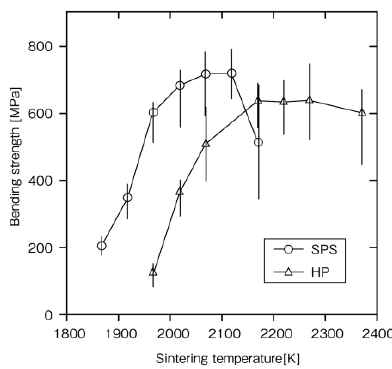
Figure 19. Dependence of bending strength on the sintering temperature in the SPS- and HP-consolidated SiCs.